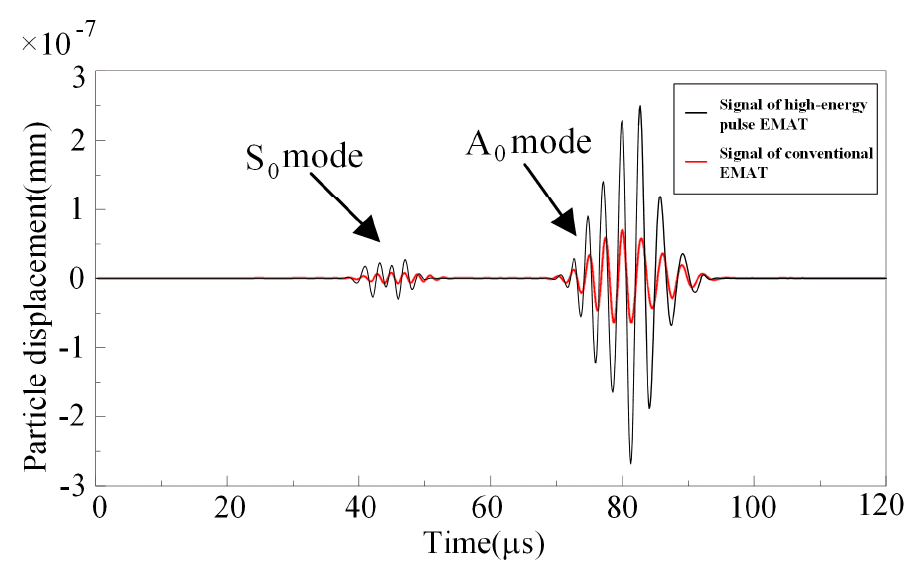
Figure 5. The received signals of high-energy pulse EMAT and conventional EMAT at the lift-off distance h = 0 mm in the simulation.